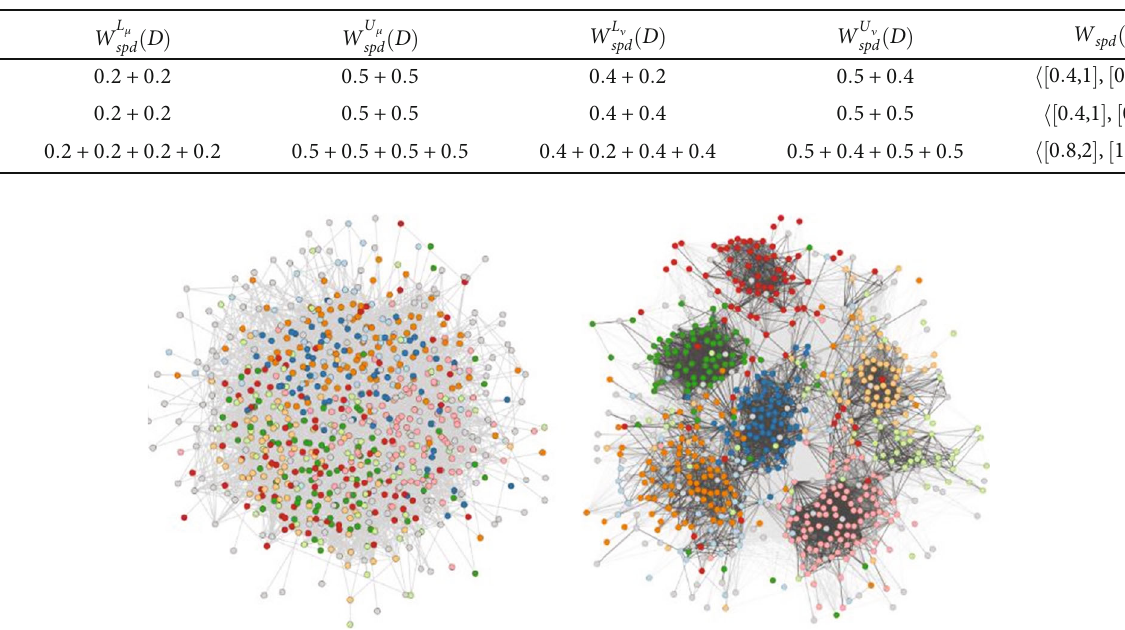
Figure 7: Scienti fi c community network of